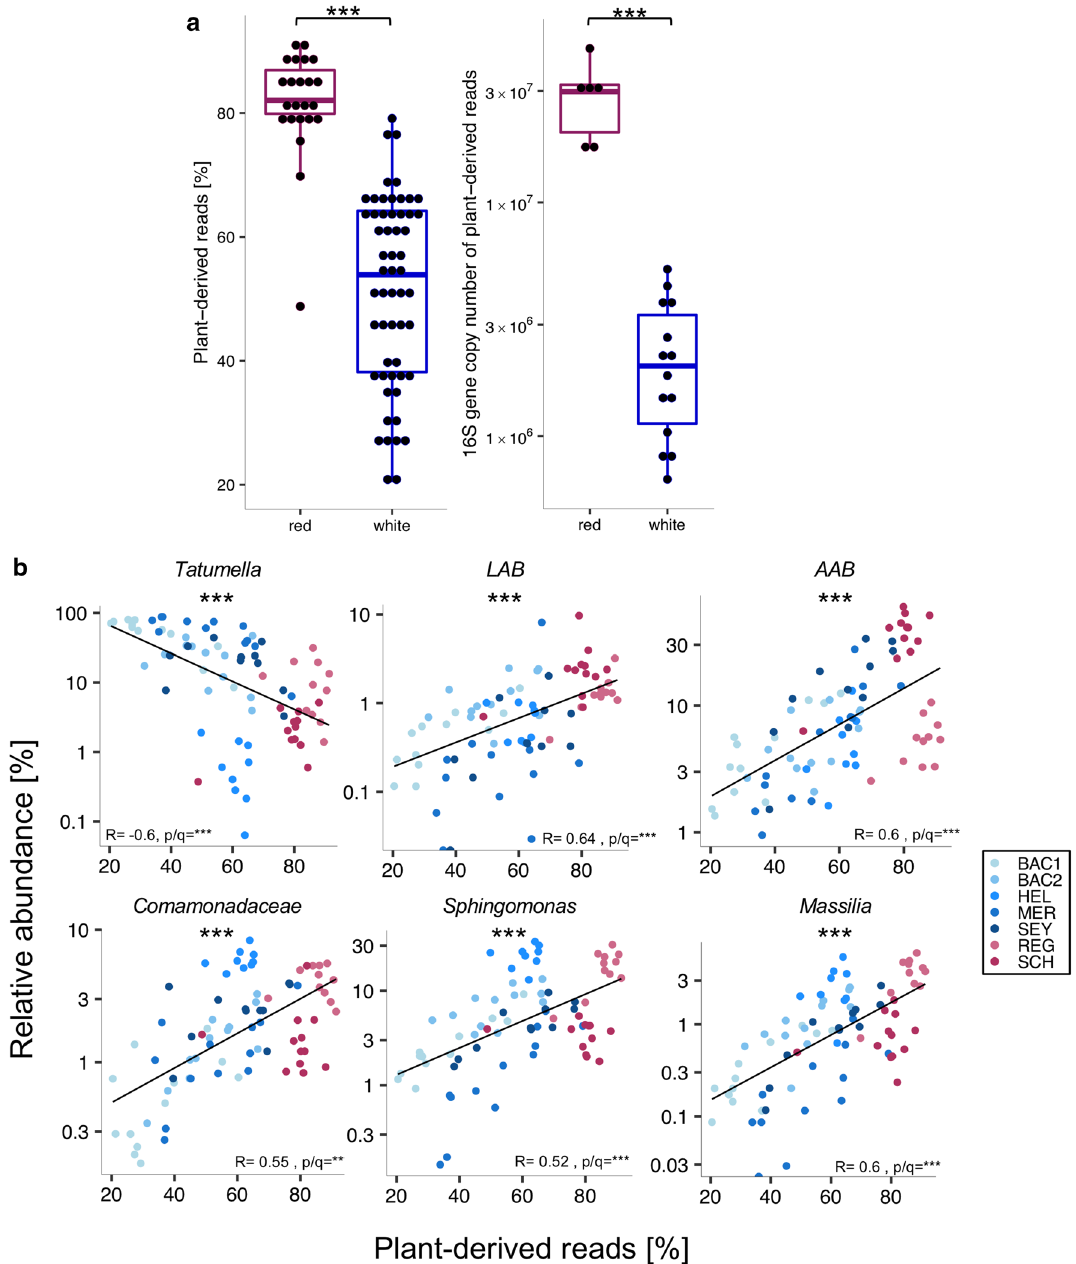
Figure 6. Plant-derived read fractions were correlated with the relative abundance of Tatumella , AAB, LAB and other taxa in wine. Significance was calculated based on Wilcoxon rank-sum test ( a ) and Spearman’s rank correlation test ( b ), all corrected with the Benjamini–Hochberg procedure, with ns = not significant, ***p/q < tenfold more genomes than white wines. While not significant after correcting for multiple tests (q > 0.05), there was a clear trend towards increasing 16S rRNA gene copy numbers during white wine fermentation (p < 0.05), which resulted in comparable densities in red and white wines by the end of the one-week observation period. However, in our longitudinal analysis, fermentation time was associated with only moderate bacterial micro- biota changes, as few bacterial taxa increased or decreased during fermentation and compositional differences between time points were small compared to those seen between wine types and batches. Calculating the fraction of taxon-specific 16S rRNA genes based on relative abundance values from the amplicon sequence analysis, we show that increases in overall 16S rRNA gene copy number density are mostly due to increased abundance of Tatumella , suggestive of active proliferation of this bacterial genus. Species from the genus Tatumella have been associated with fruits, including pineapple and mandarin orange, but also soil samples and even human patient